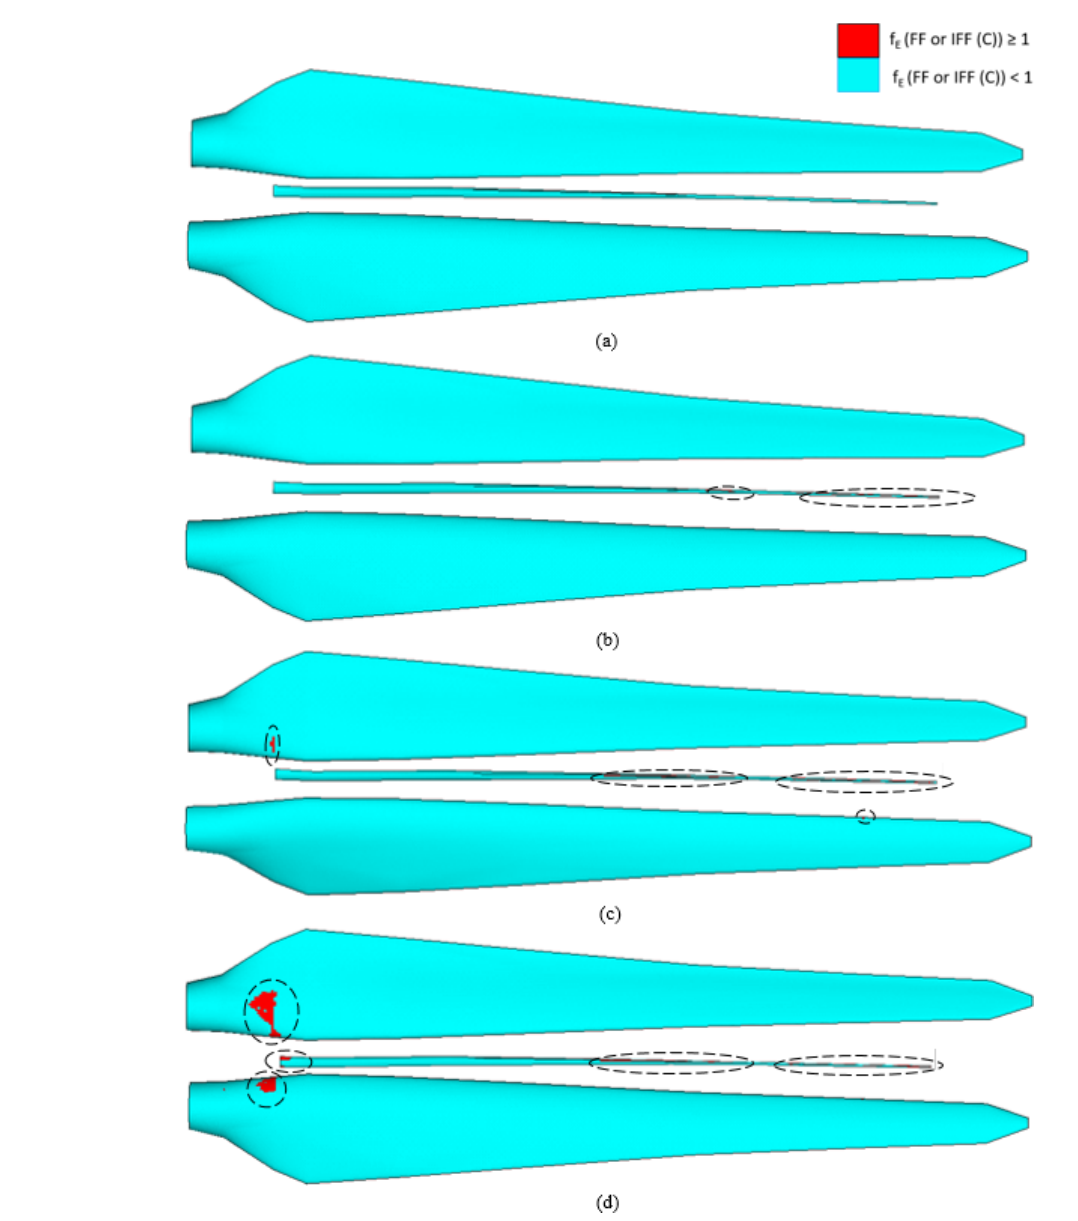
Figure 22. Element failure progression in the pressure side, internal flange and suction side of the blade (from top to bottom in a panel) at (a) 100%, (b) 210%, (c) 309% and (d) 314% of extreme edgewise